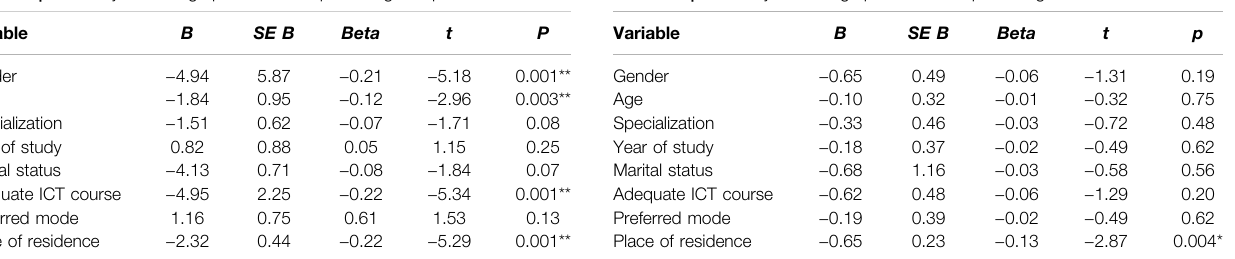
TABLE 3 | Summary of demographic variables predicting computer skills.